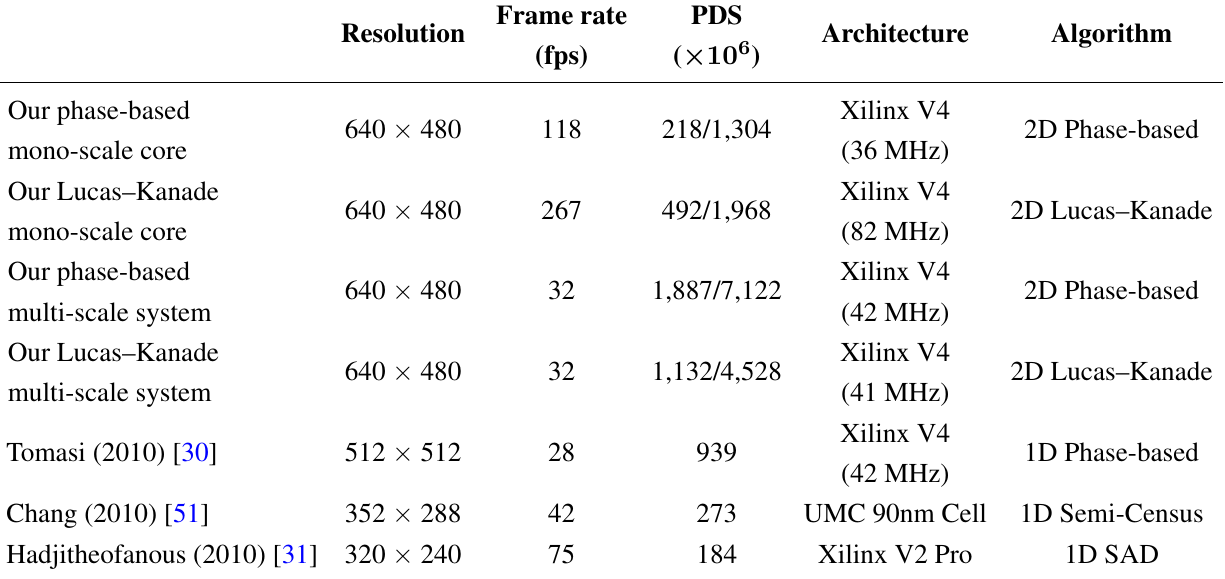
Table 1. Disparity performance comparison (works sorted by date of publication).